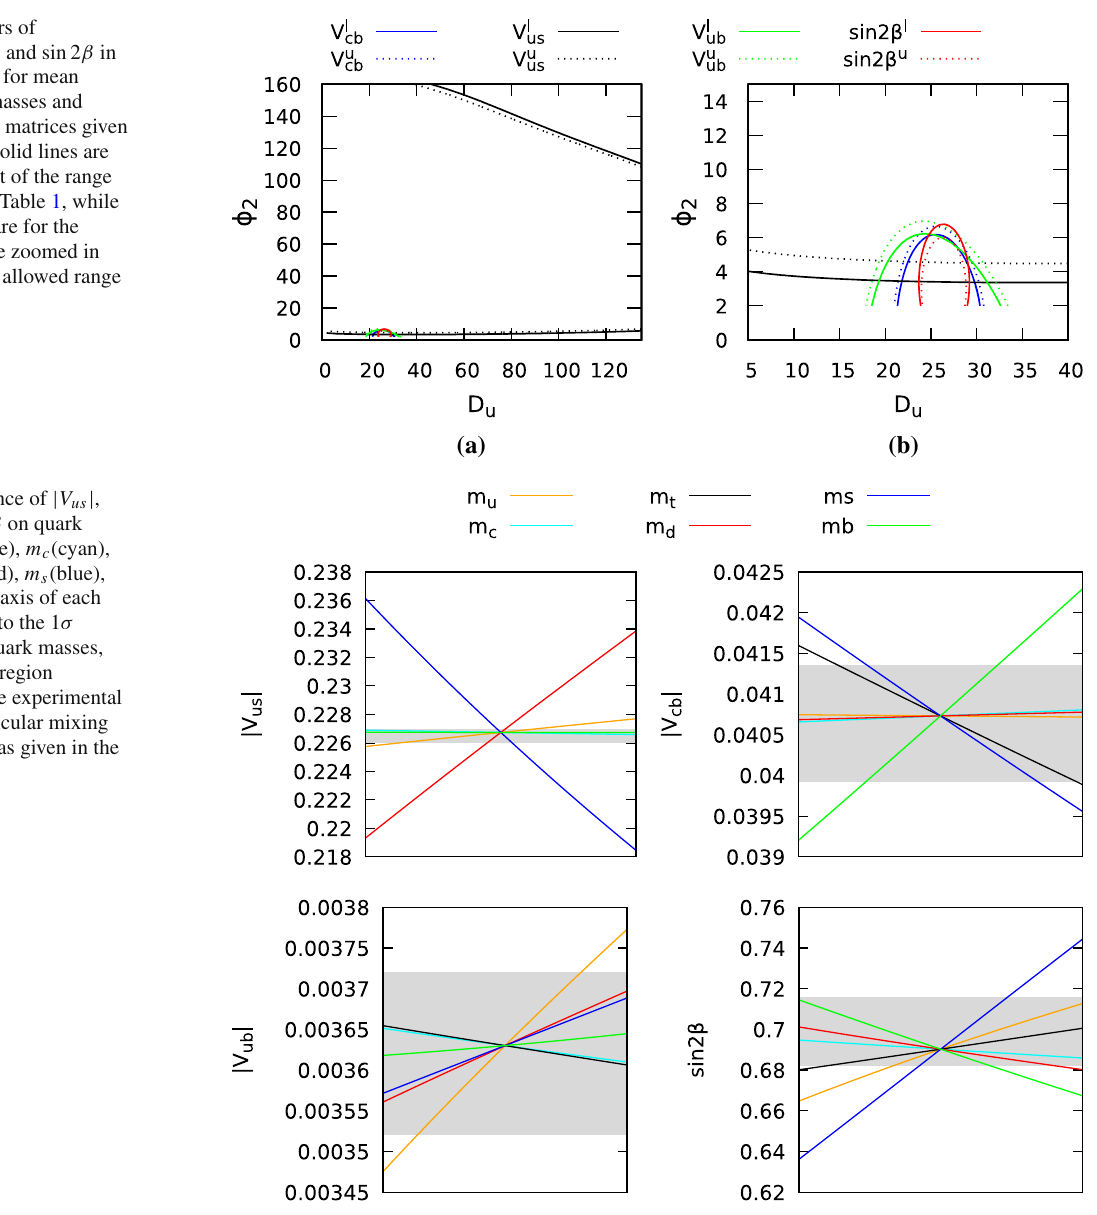
Fig. 4 a Contours of | V | , | V | , | V | and sin 2 β in us cb ub D u and φ 2 plane, for mean values of quark masses and D d = 0 . 4, for the matrices given in Eq. (13). The solid lines are for the lower limit of the range mentioned in the Table 1, while the dashed lines are for the upper limit. b The zoomed in region of a in the allowed range